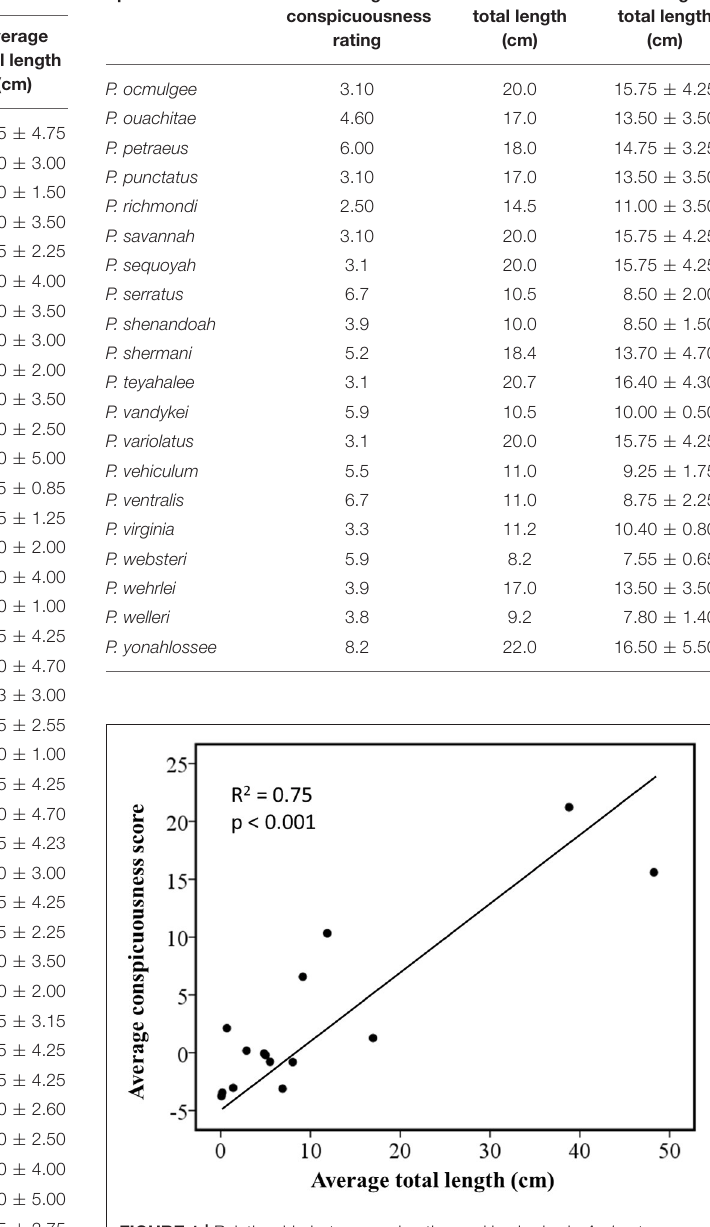
FIGURE 1 | Relationship between coloration and body size in Ambystoma salamanders estimated by phylogenetically independent contrasts using a gradual model of evolutionary change. The figure shows standardized contrasts for average total length against standardized contrasts for average ratings of